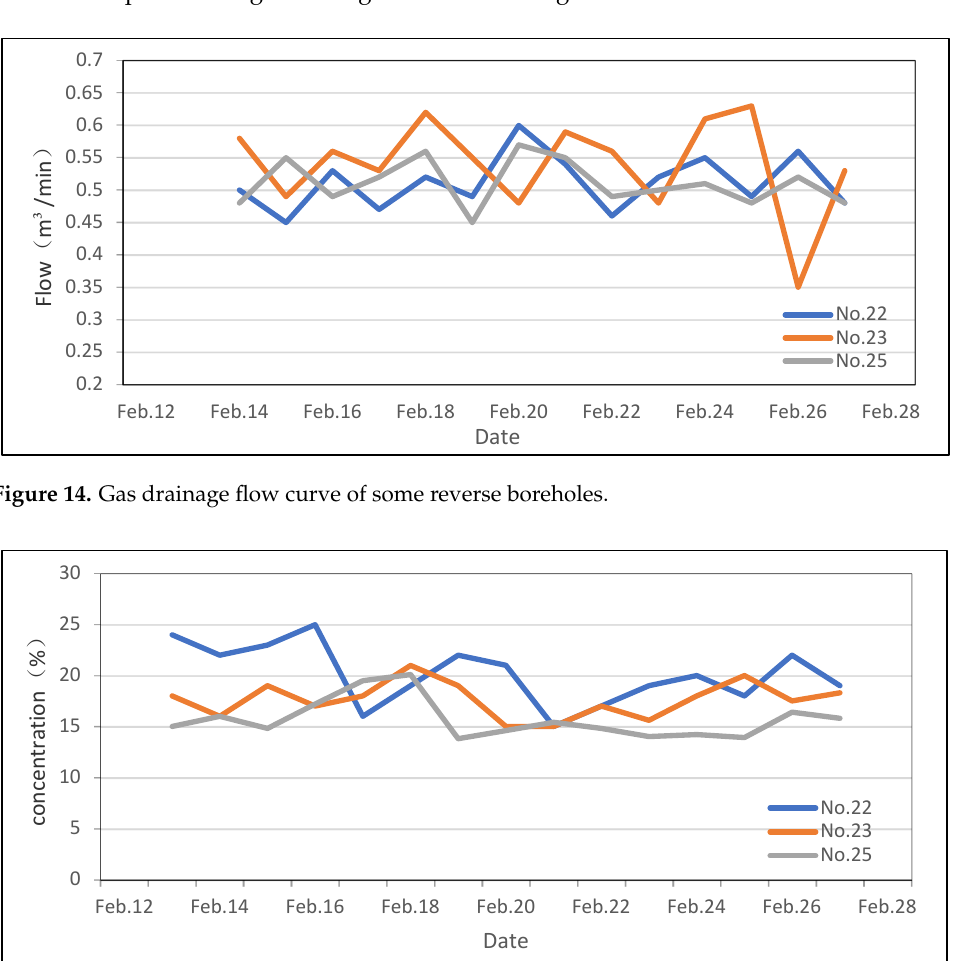
Figure 13. Gas concentration curve of some boreholes in No. 8 drilling field of Lane XV1306.